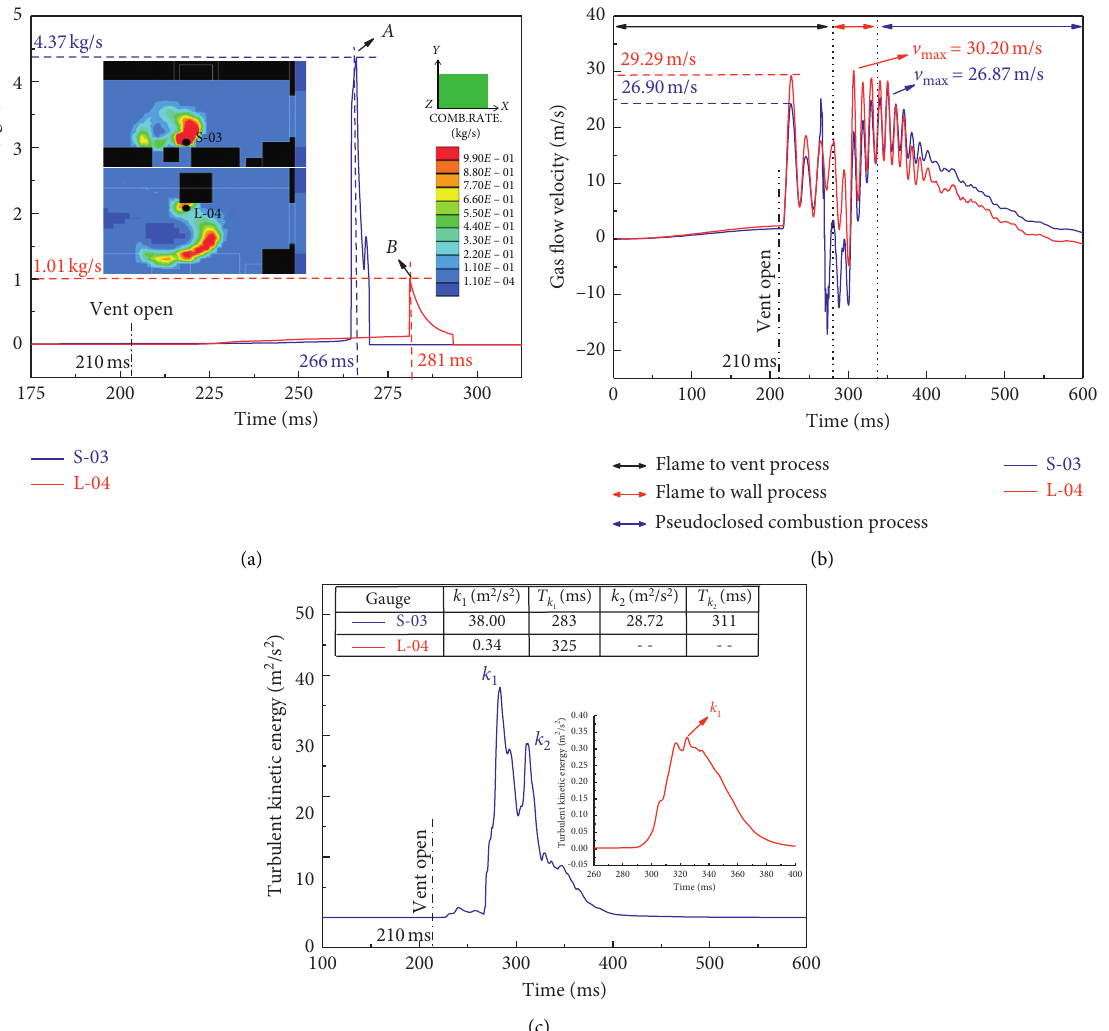
Figure 14: Comparison of flow-field parameters in the vicinity of refrigerator/range hood. (a) Combustion rate. (b) Gas flow velocity. (c) Turbulent kinetic